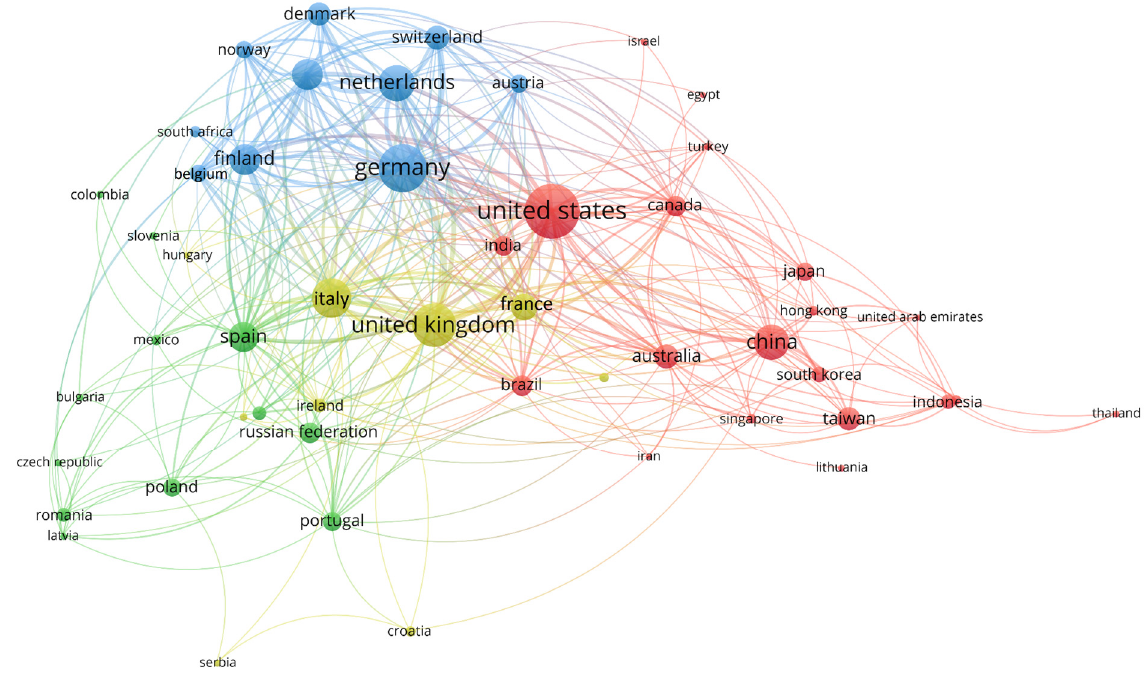
Figure 7. Co-authorship network of countries in the BM&OI literature.